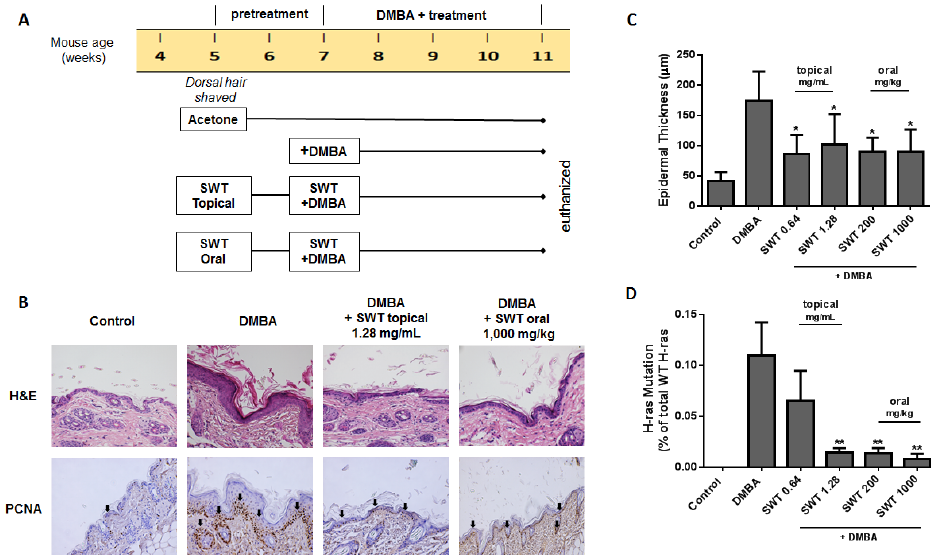
Figure 4. Effects of SWT on DMBA-induced hyperplasia and mutation of H- ras in SENCAR mice. ( A ) Experimental design; ( B ) microphotographs of H&E staining, and immunohistochemistry of PCNA to depict DMBA-induced skin hyperplasia and cell proliferation activity. Black arrow: positive PCNA cells in stratum basale of epidermis; ( C ) induction of epidermal thickness with DMBA and the effect of SWT. Data represents the mean ± standard error from repeated measurements of one sample at 20 locations along tissue; and ( D ) the percentage of H- ras codon 61 mutations (CAA → CTA) detected using castPCR. Statistical analysis was performed by ANOVA with Dunnett’s multiple comparisons post-hoc test. *: p < 0.05; **: p < 0.01, compared to DMBA only group ( n = 6–8).